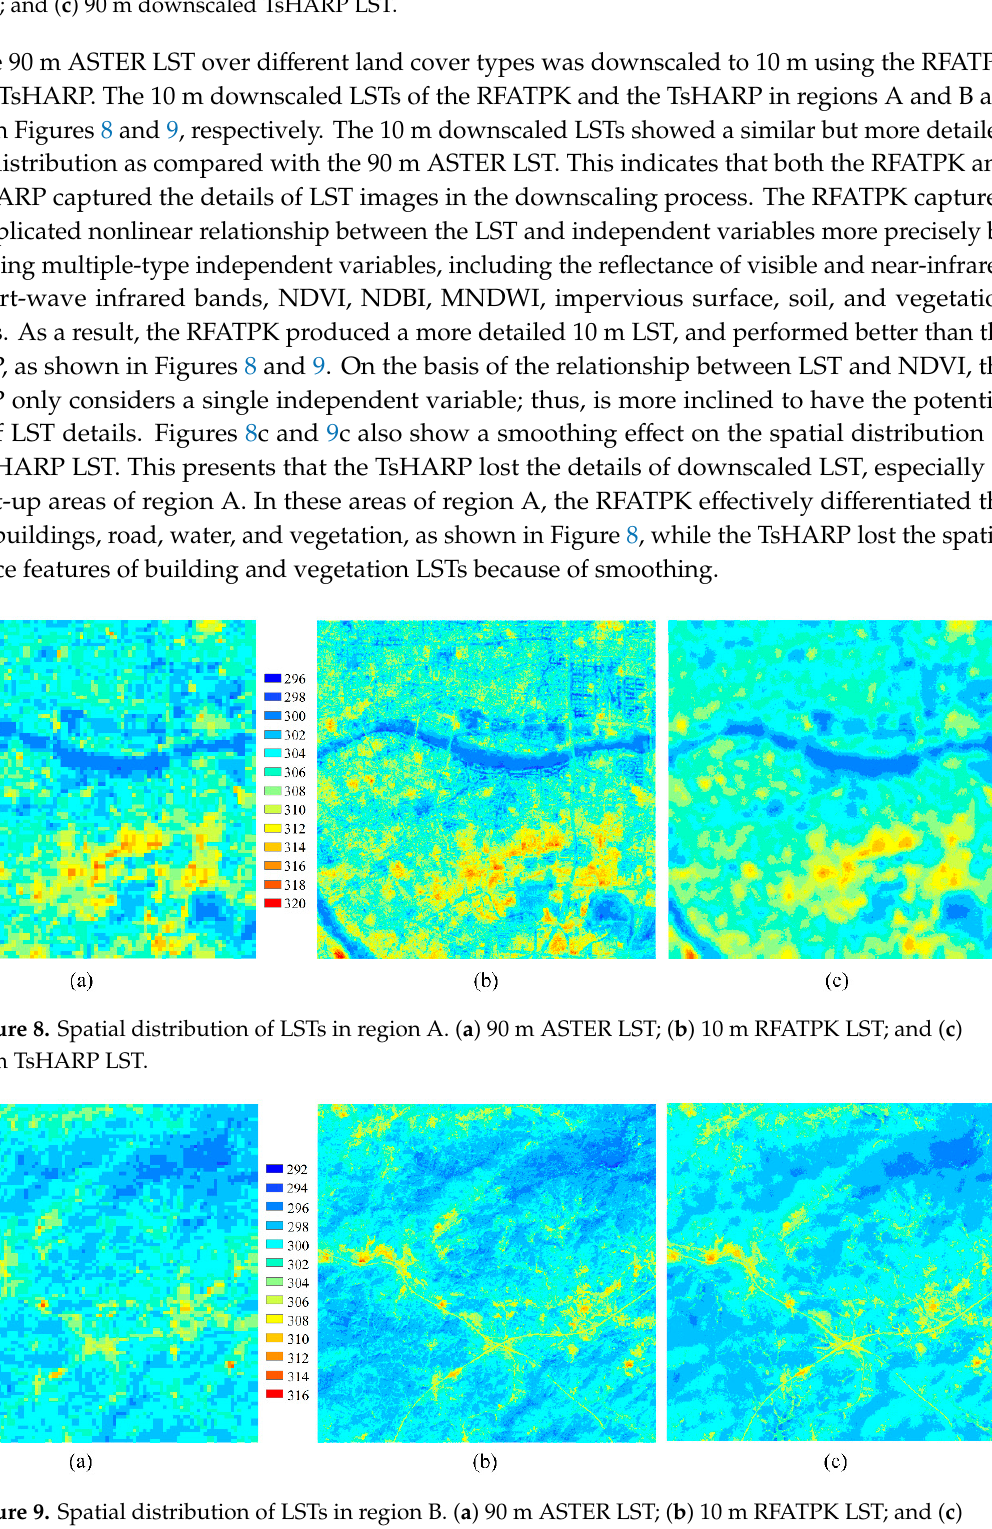
Figure 7. Spatial distribution of LSTs in region B. ( a ) 90 m ASTER LST; ( b ) 90 m downscaled RFATPK LST; and ( c ) 90 m downscaled TsHARP LST.